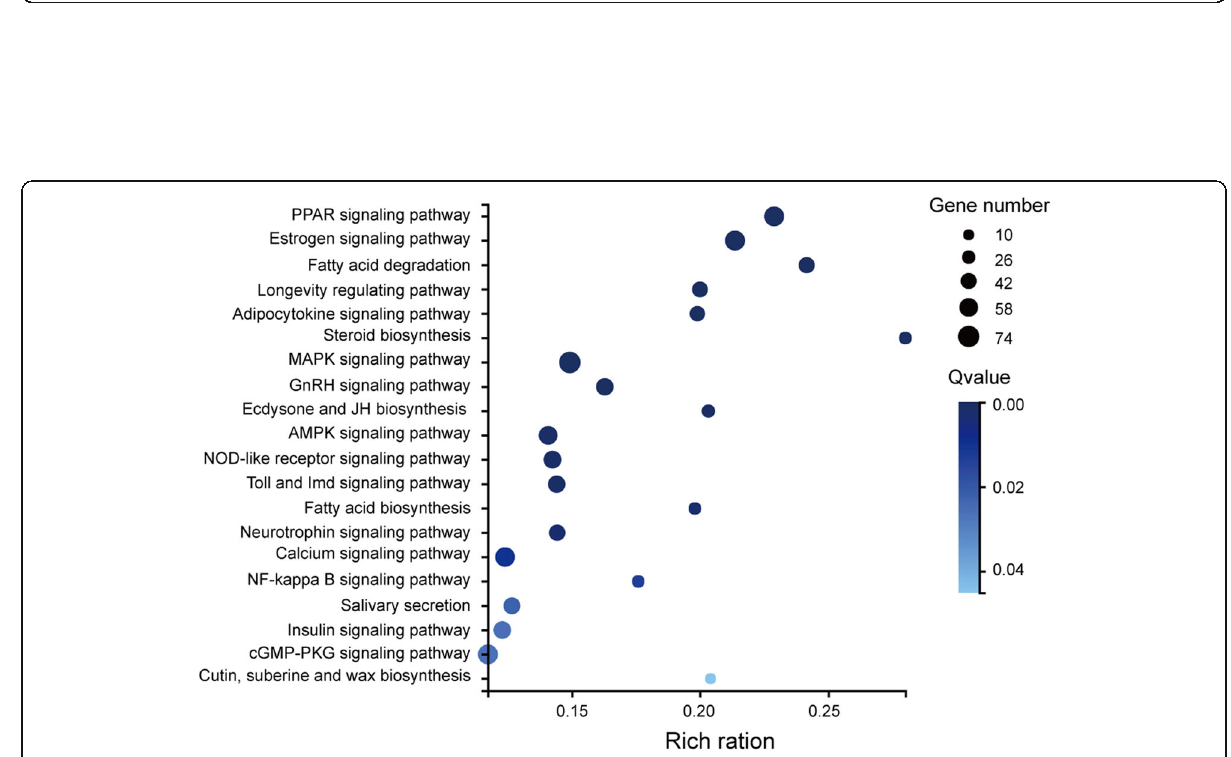
Fig. 5 Significantly enriched up-regulated KEGG pathways. The up- and down-regulated DEGs were performed KEGG pathways enrichment separately. The rich ratio, gene number and Q-value in each enriched up-regulated signaling pathways were shown. Significantly enriched pathways were judged at P < 0.05 in hypergeometric